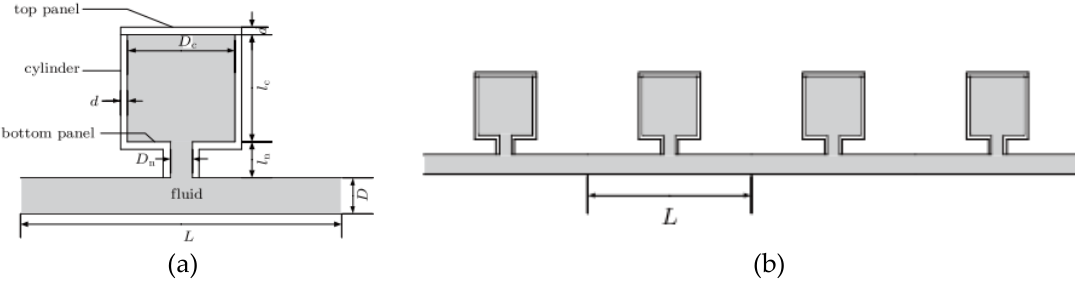
Figure 10. Schematic diagram of the proposed structure: ( a ) Sketch of an elastic HR; ( b ) Sketch of an infinite periodic pipe with elastic HRs [40].